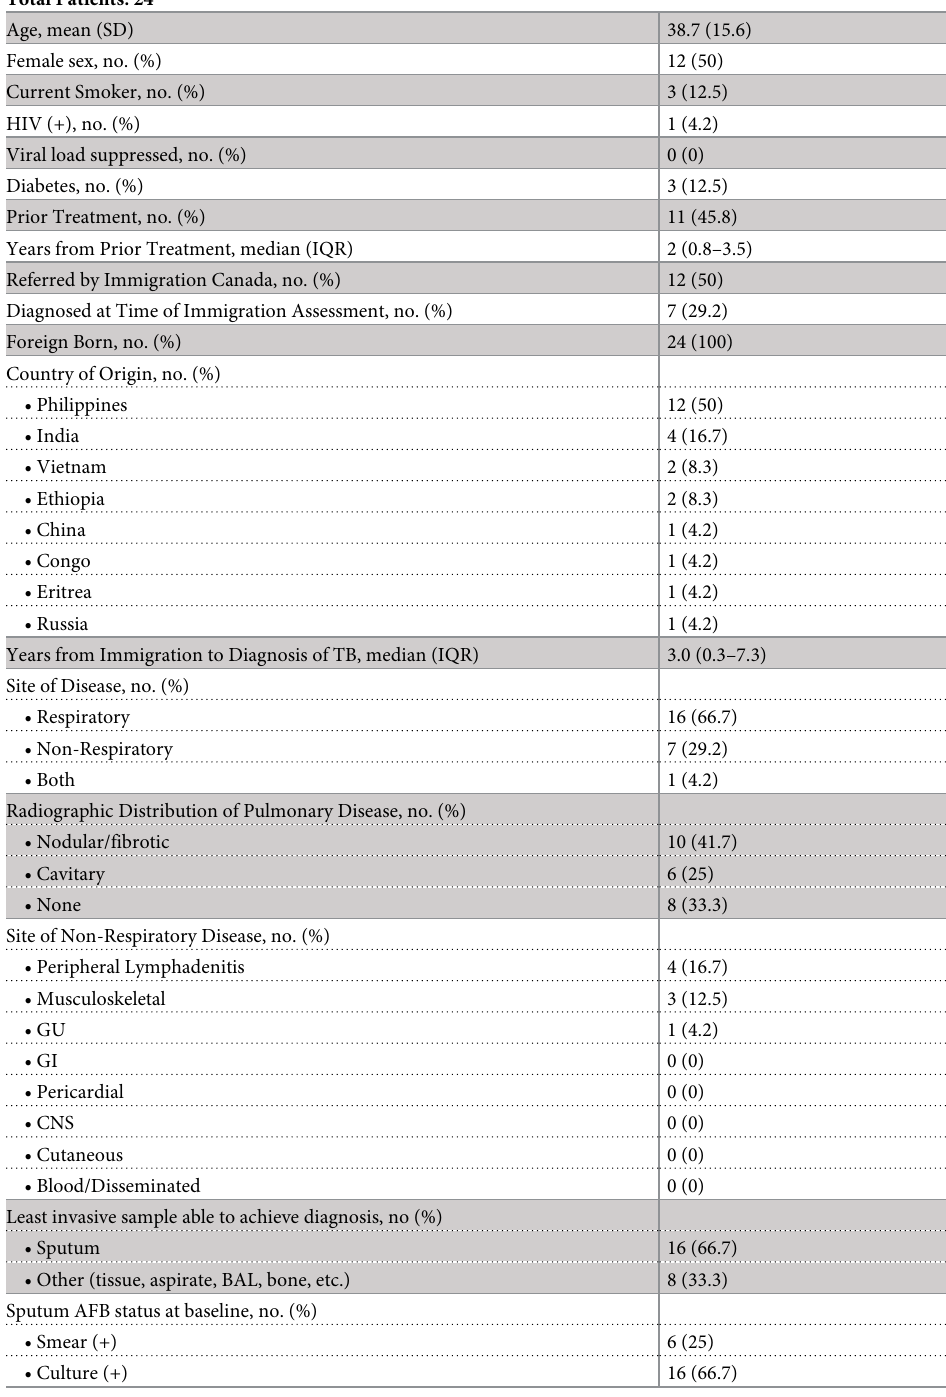
Table 1. Baseline demographics and clinical features. Total Patients: 24 Age, mean